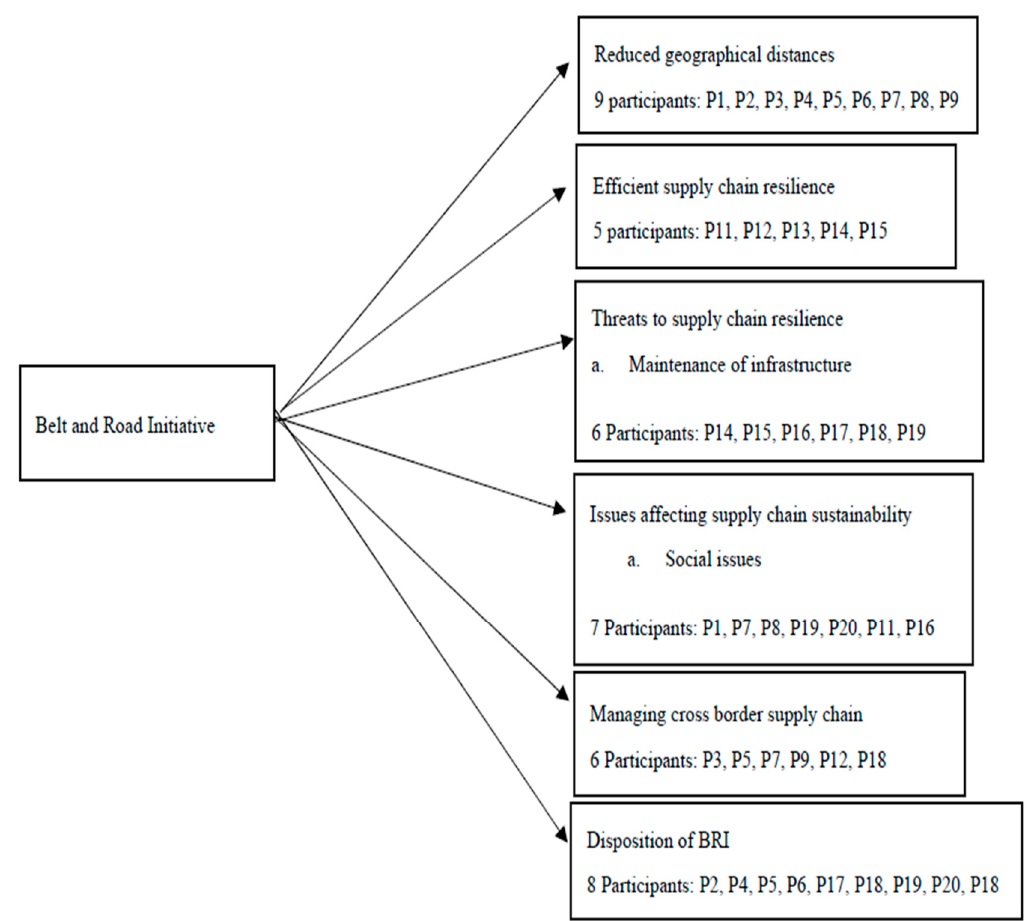
Figure 3. Proposed model of the impact of BRI on supply chain management.